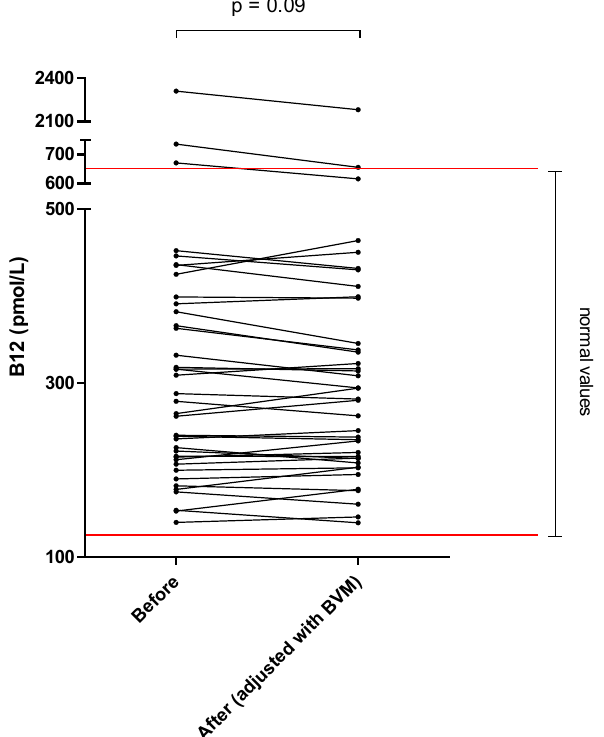
Figure 5. Vitamin B12 (cobalamin) blood concentration before and after one 4 h-HDF session (paired t -test).